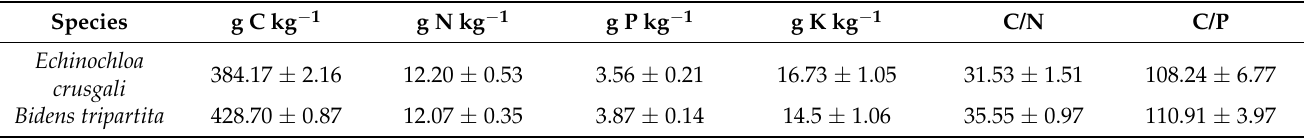
Table 1. Initial value of nutrient contents and their ratios in the litter of Echinochloa crusgali and Bidens tripartita . Species g C kg − 1 C/P Echinochloa 384.17 ± 2.16 crusgali Bidens tripartita 428.70 ± 0.87 Note: Data are means ±